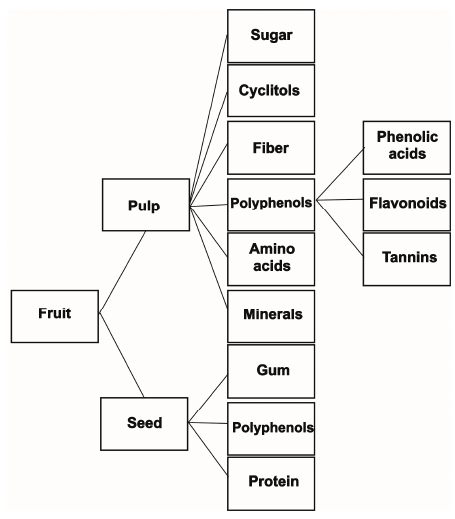
Figure 1. Main chemical constituents in carob pulp and seed with nutritional and health-promoting properties.